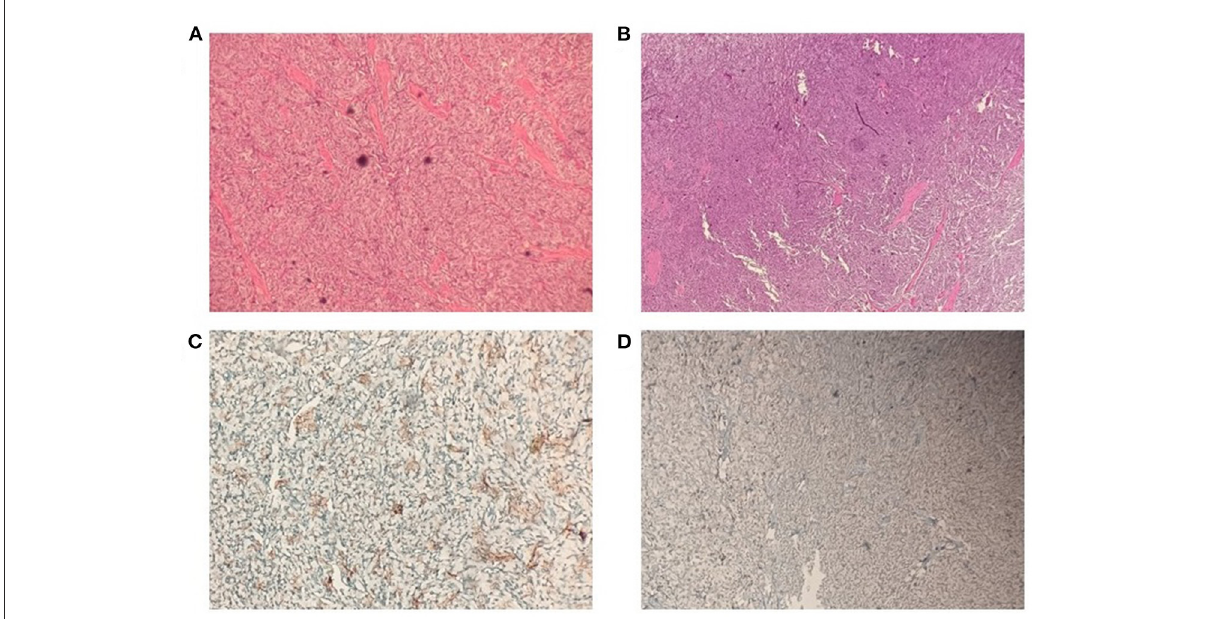
FIGURE3 Microscopic examination of pheochromocytoma. (A,B) Haematoxylin and eosin staining. (C) Immunohistochemical staining of tumor cells was positive for chromogranin A. (D) Immunohistochemical staining of tumor cells was positive for